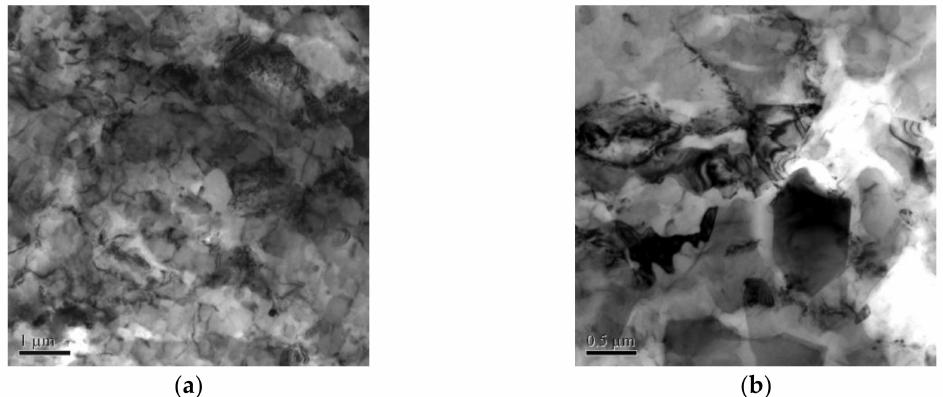
Figure 7. TEM images of alloy N1 at 96% cold rolling reduction. ( a ) with 2550 times magnification and ( b ) with 5000 times